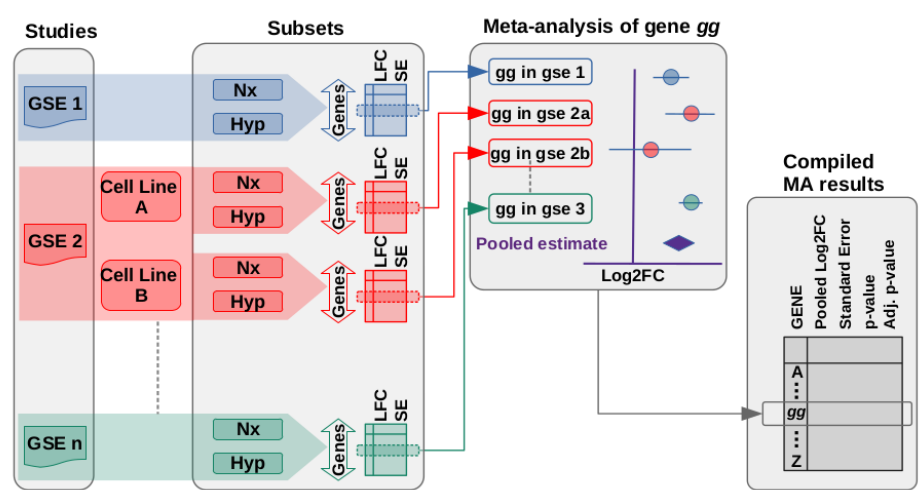
Figure 2. Integration of studies and gene-level meta-analysis. Normoxic (Nx samples) and hypoxic (Hyp samples) replicates from the relevant studies (“GSE1”, “GSE2”, ...“GSEn”) were processed to produce a table recording the effect of hypoxia on the expression of each gene (Log 2 fold-change, labeled as “LFC”) and the standard error associated to this estimation (“SE”). Complex studies were subdivided to produce minimal subsets of data (see Figure 1). Then, the results obtained for each individual gene (represented by gene “ gg ” in the figure) were integrated into a random-effects model meta-analysis to produce a pooled estimate of the effect of hypoxia on each gene. Note that a meta- analysis is performed for each individual gene. Finally, the results of the gene-level meta-analyses were integrated into a single list (“Compiled MA results”). p -values from individual meta-analyses were corrected for